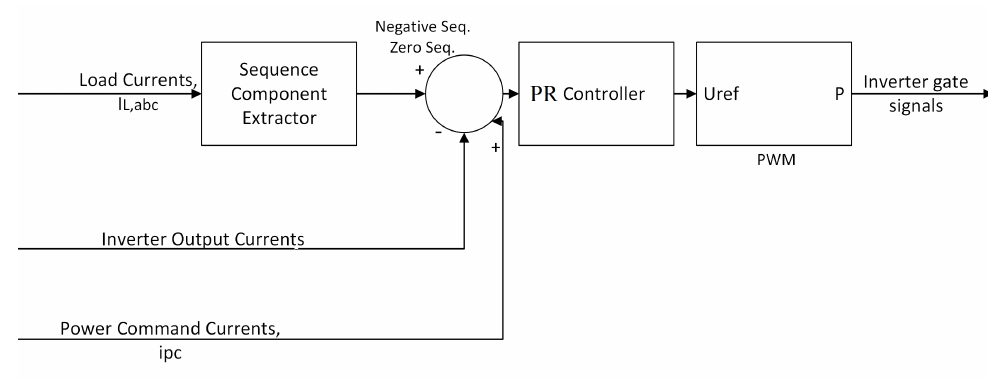
Figure 3. The current control technique using the PR